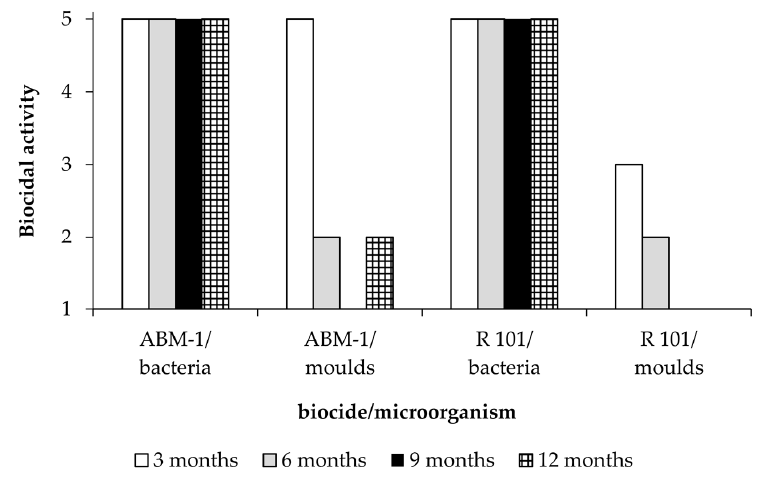
Figure 4. Effectiveness of biocides (ABM-1 at 8%, Rocima 101 at 8%) applied by fogging.